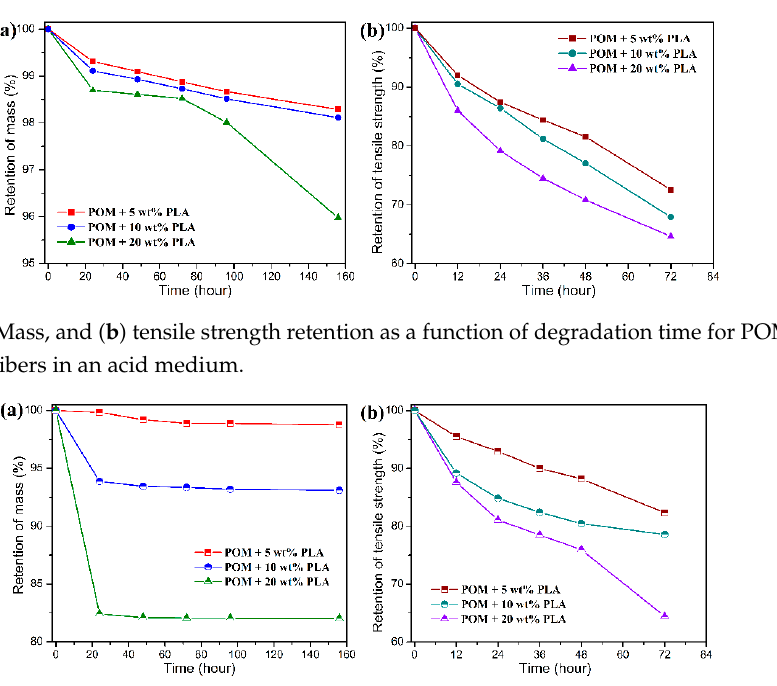
Figure 13. ( a ) Mass, and ( b ) tensile strength retention as a function of degradation time for POM / PLLA bicomponent fibers in an alkali medium.